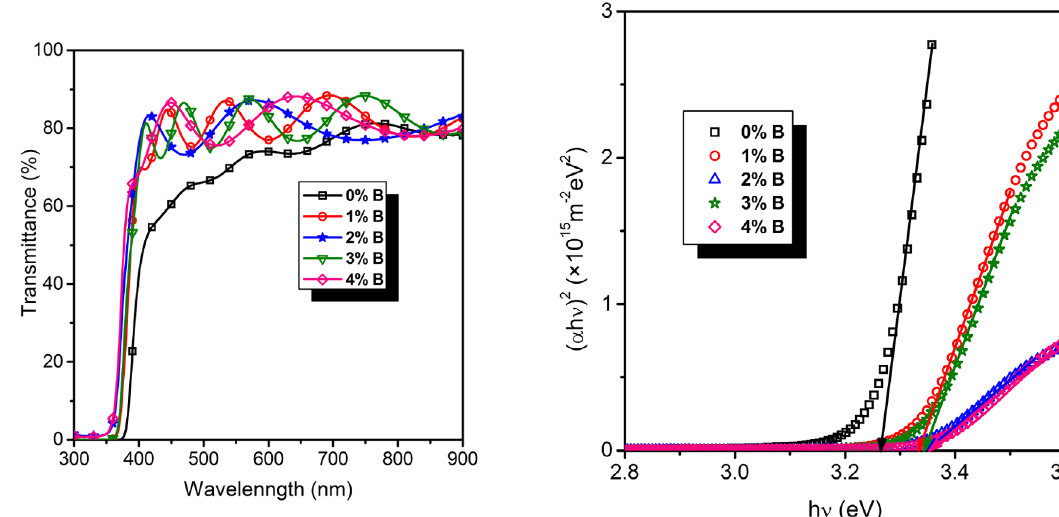
Figure 5. Plot of (αhν) 2 v/s hν for spray pyrolysed B-N codoped ZnO thin films with different B concentration for band gap energy (Eg)